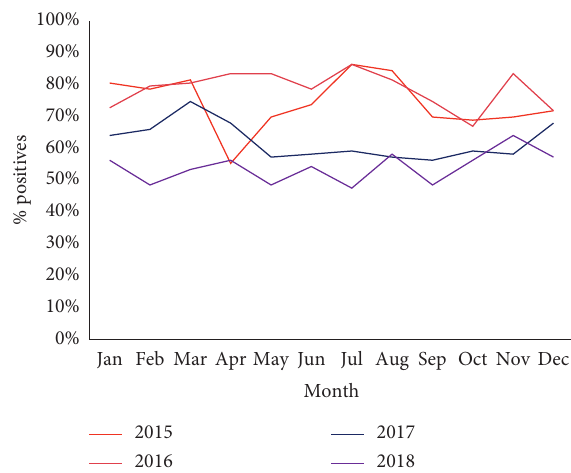
Figure 2: Monthly distribution of malaria incidence, Central African Republic, 2015–2018.